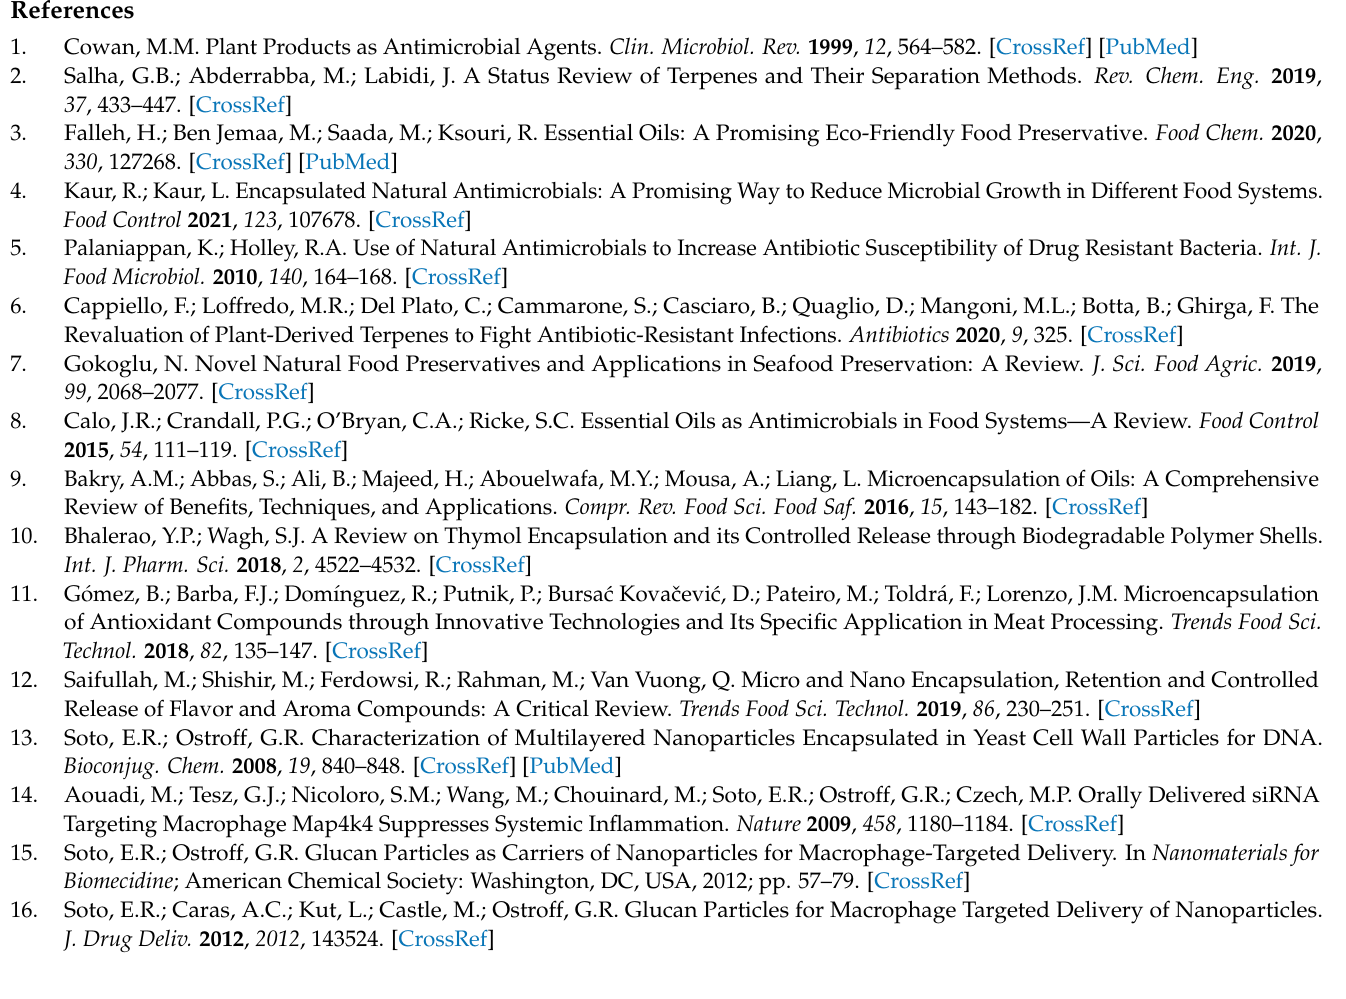
and Figure S3: Kinetics of terpene release showing similar release pattern for geraniol, eugenol, and thymol from YP GET